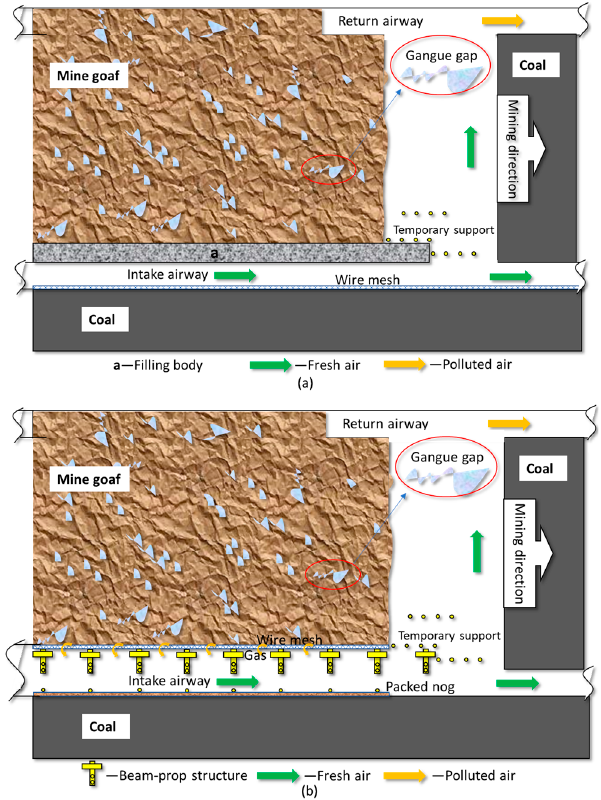
Figure 4. Schematic diagram of conventional mining method with gob-side entry: ( a ) gob-side entry retaining technology without roadside filling (GER-WRF) and ( b ) gob-side entry retaining technology with roadside filling (GER-RF).